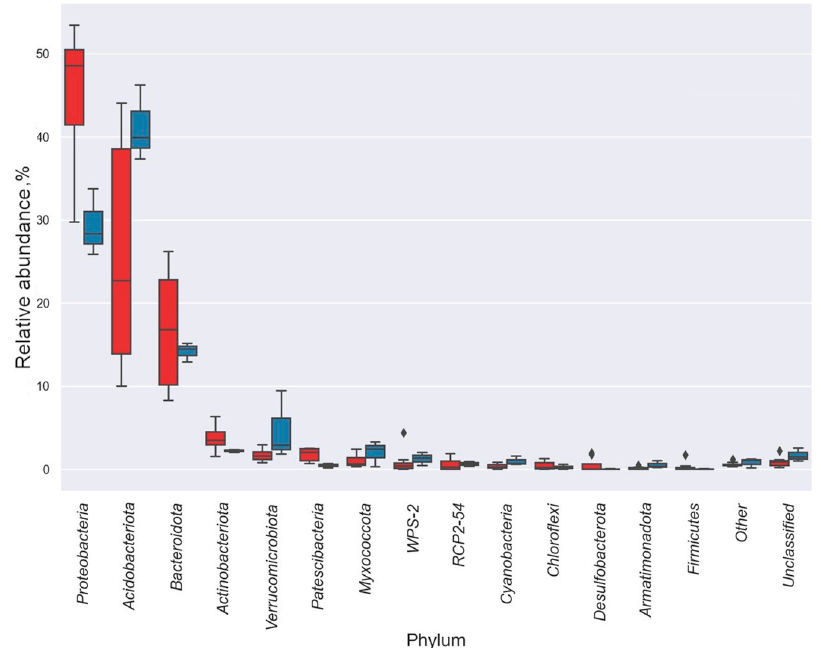
Figure 6. Comparison of the bacterial community structure at the phylum level across all studied sites. Abbreviations: blue boxplots—undisturbed sites, red boxplots—disturbed sites; outliers in a data set are indicated by the blue rhombus. See Table 6 for